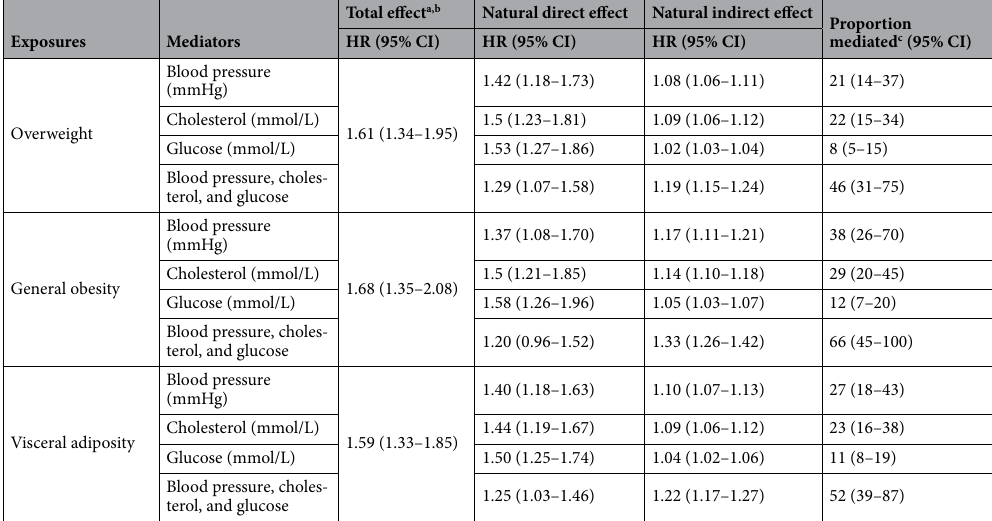
Table 2. Total, direct, and indirect effects of overweight and adiposity on cardiovascular diseases (CVDs) using a parametric method without considering exposure-mediator interaction. MI body mass index; CI confidence interval; HR hazard ratio; WC waist circumference. a Compared with normal-weight participants for general adiposity and WC < 90 cm as a reference for central adiposity. b All models were adjusted for age, gender, smoking, physical activity level, educational status, and family history of CVDs. c The direct, indirect, and total effects were estimated for each bootstrap resampling.